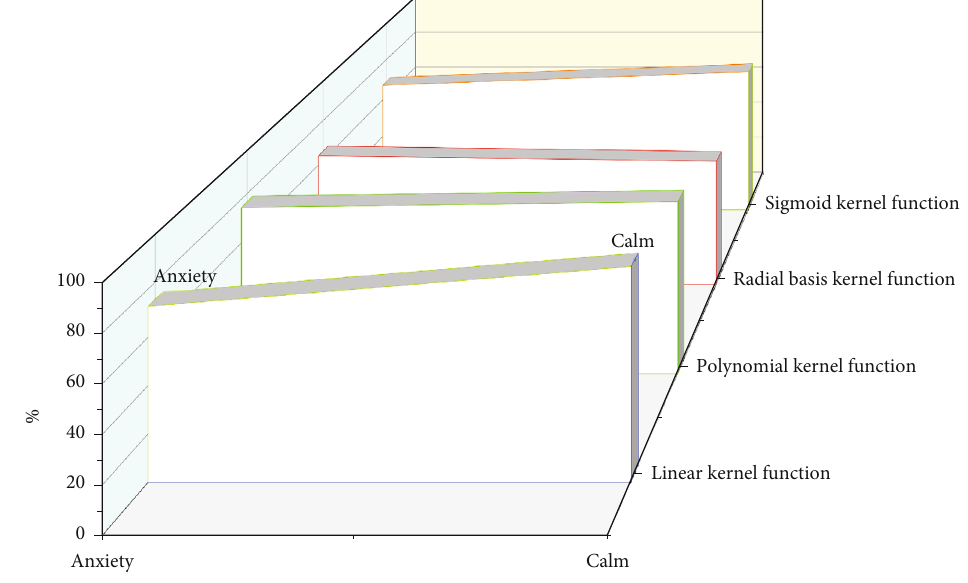
Figure 2: Comparison of results of recognition